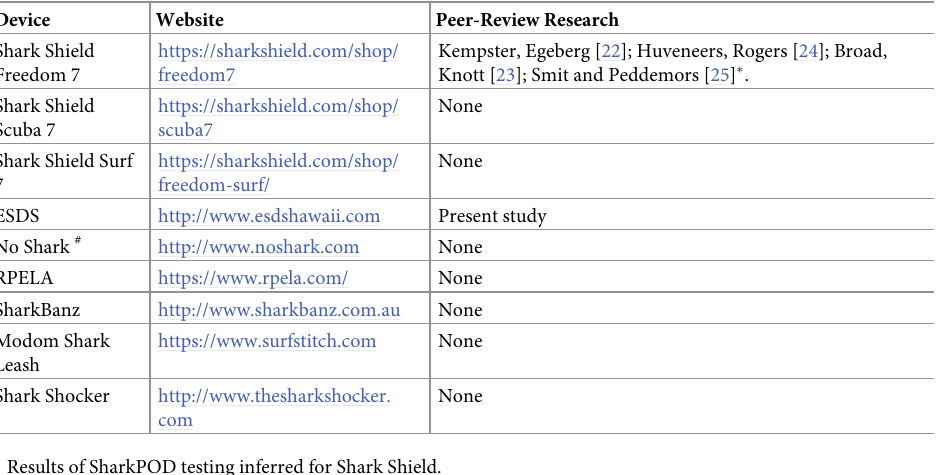
Table 1. Commercially available shark deterrents that target the electrosensory